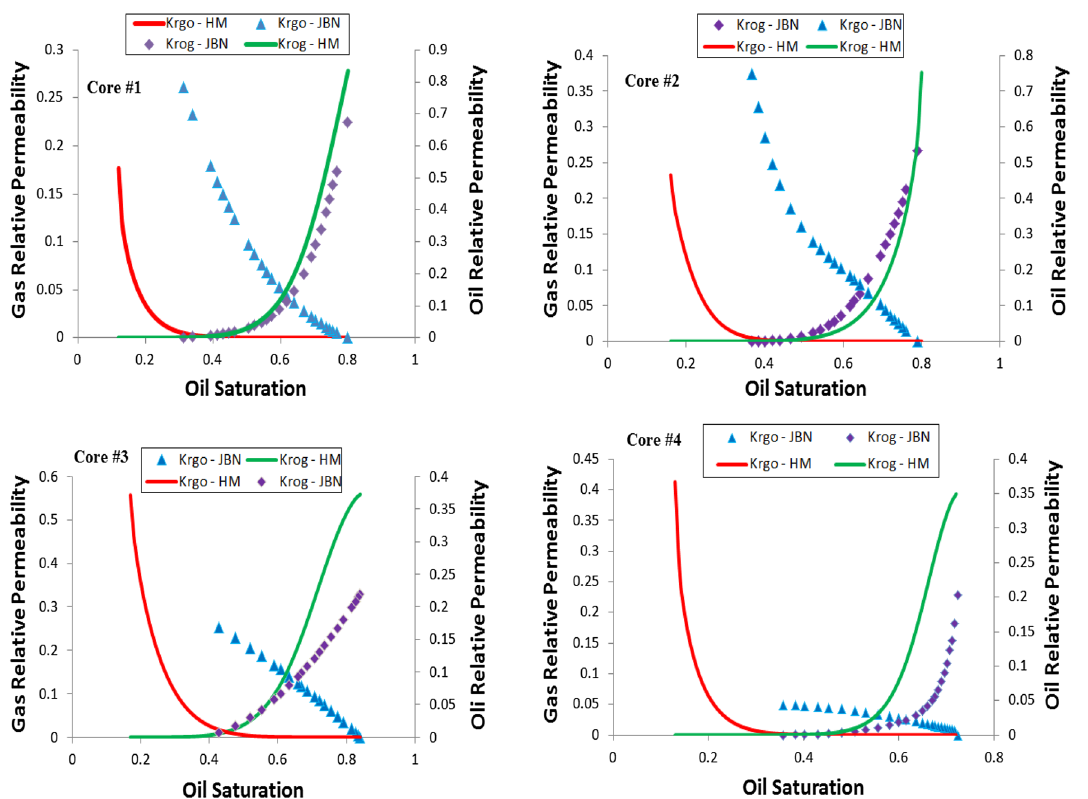
Fig. 7 Oil and gas relative permeability values versus oil saturation estimated by the history-matching technique (HM) and the analytical method (JBN) for various